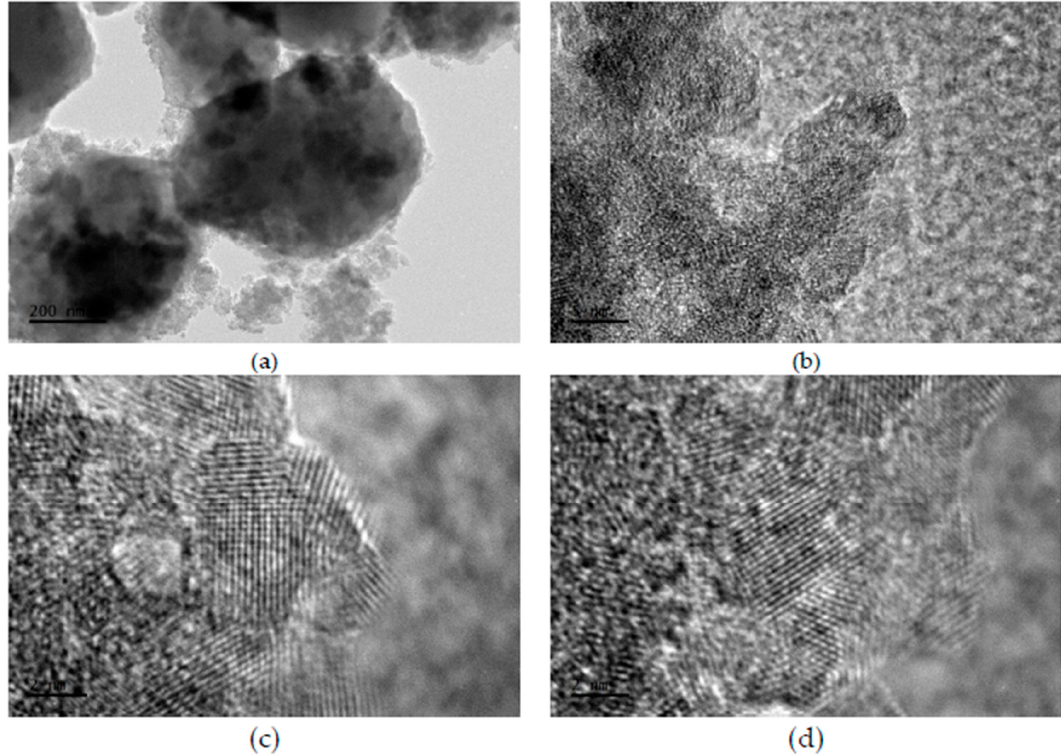
Figure 3. Transmission electron microscope (TEM) images of carbon-coated CD-aTiO 2 for the DTiB-04 photocatalyst, ( a ) particles conglomerates at 200 nm (see Figure 1b), ( b ) zoom of image ( a ) to 5 nm and ( c , d ) nanocrystals of image ( b ) to 2 nm.